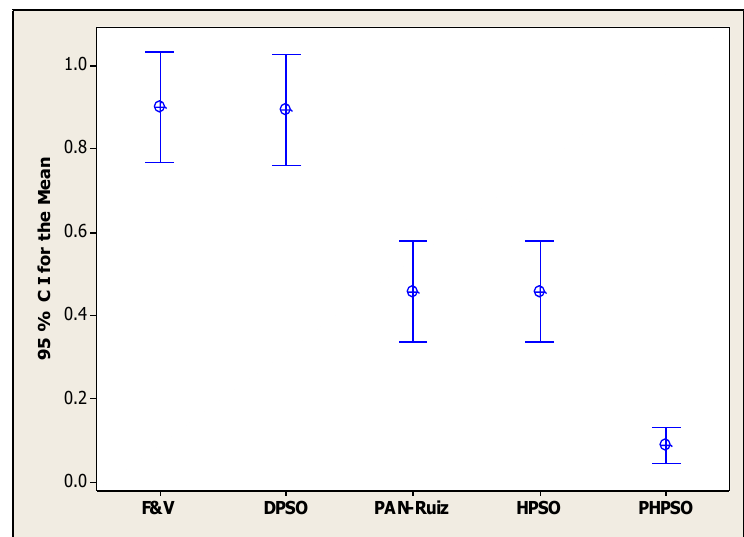
Figure 1. Means and 95% confidence intervals for different algorithms for ta001 to ta110.